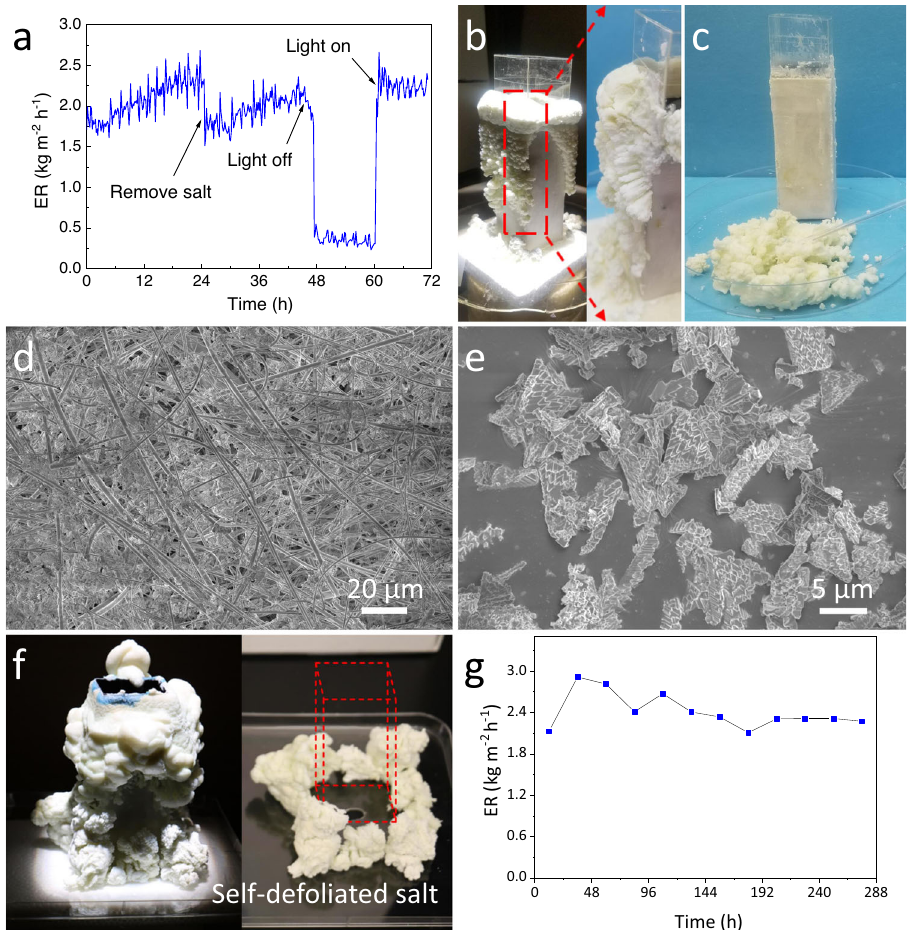
Fig. 4 Solar evaporation and crystallization behavior of real seawater brine in the presence of NTA. a The water evaporation rate of the solar crystallizer using concentrated SWRO brine with 8.4 ‰ NTA; b photo image of the solar crystallizer and accumulated salt after 24-h operation; c photo image of the solar crystallizer after removing accumulated salt after 24-hour operation; SEM images of d QGF membrane after 24-h operation and e the salt crystals collected from the outer surface; f photo image of the solar crystallizer and self-defoliated salt after 48-h operation (the red dotted frame represents the position of removed solar crystallizer); g the water evaporation rate of the solar crystallizer during the 288-h operation (each point on the curve was the average evaporation rate of 24